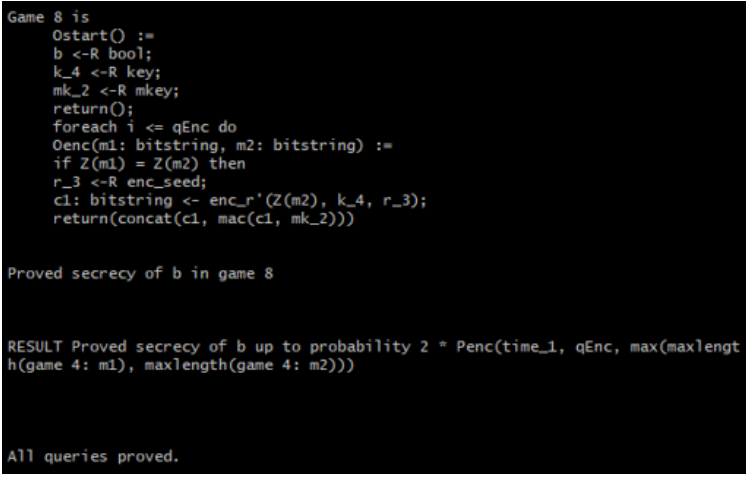
Figure 11. Final Output of IND-CPA Verification of Platoon Key Update Phases.